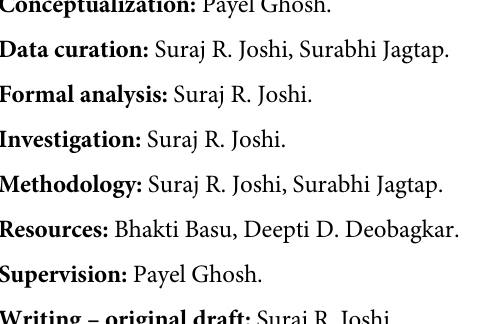
S10 Table. Average gene expression values of DR_2287 first neighbors matched with previ- ous transcriptome data. Gene expression values depicted in red are statistically significant. 0–24 hours are the PIR time points. S11 Table. List of hub genes in all modules. S12 Table. Functional analysis of close neighbors (TOM > 0.01) of hypothetical hub genes in a